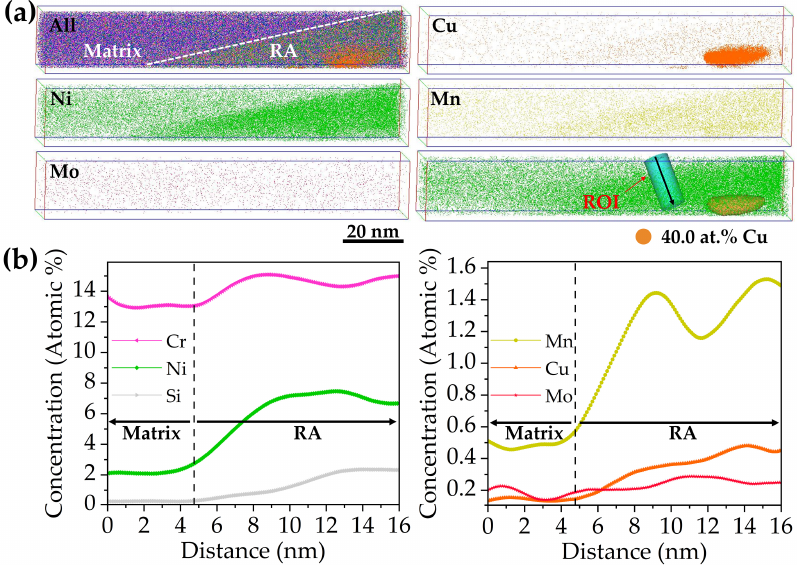
Figure 10. ( a ) The 3 ‐ D atomic probe maps of the 3Cu ‐ steel tempered at 600 °C and the region of interest (ROI) and 3 ‐ D reconstruction based on isoconcentration surfaces of 40.0 at.% Cu in the Ni atom map. ( b ) The 1 ‐ D concentration profiles of the ROI displayed by the cylinder in ( a ). (For brevity, reversed austenite is denoted as RA.)